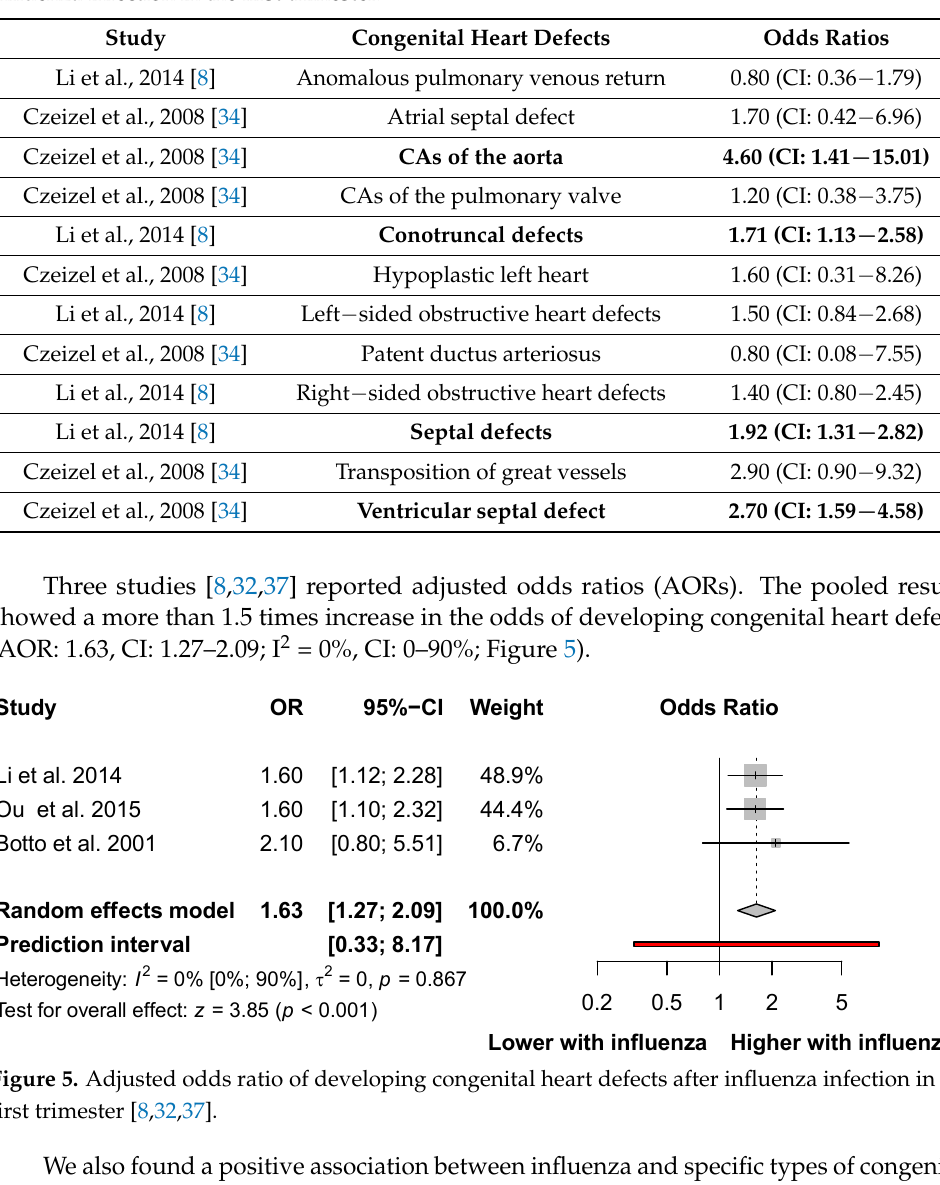
Table 3. Detailed odds ratios for developing specific congenital heart defects after influenza in the first trimester.